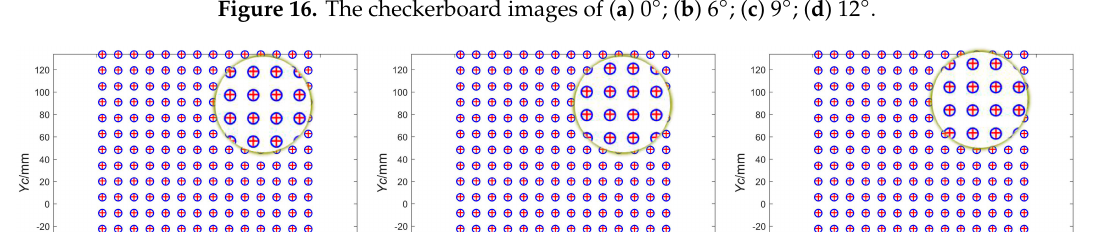
Figure 16. The checkerboard images of ( a ) 0°; ( b ) 6°; ( c )9°; ( d ) 12°.